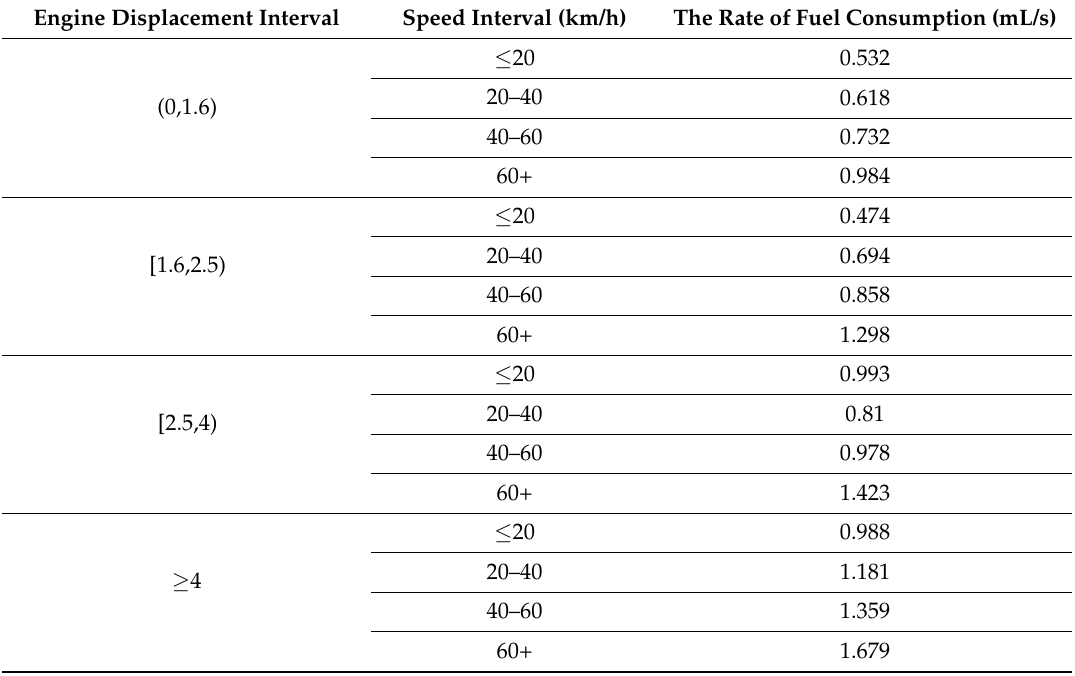
Table 7. The fuel consumption rates in each speed interval and engine displacement